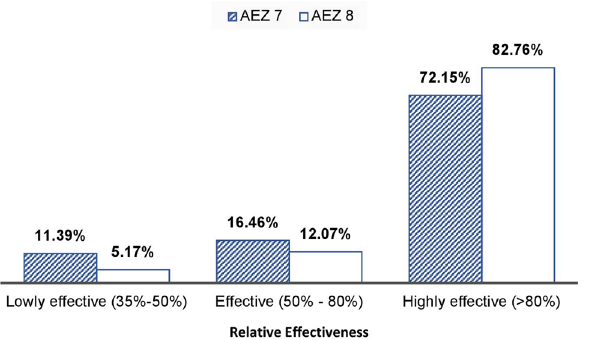
Figure 6. Summary of relative effectiveness of authenticated rhizobial isolates from agroecological zones 7 and 8 in